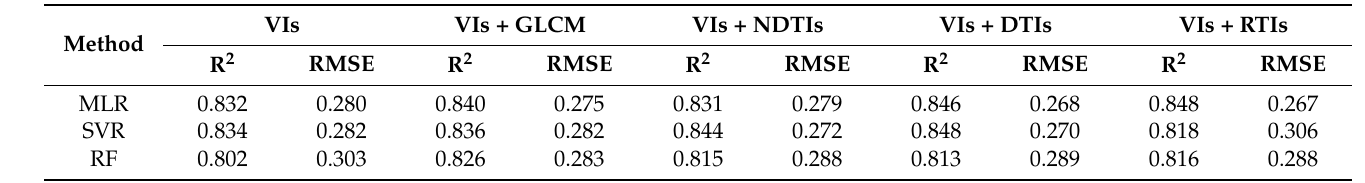
Table 7. Ten-fold cross-validated R 2 and RMSE of the multiple regression models without feature selection or data dimension reduction for maize LAI estimation.